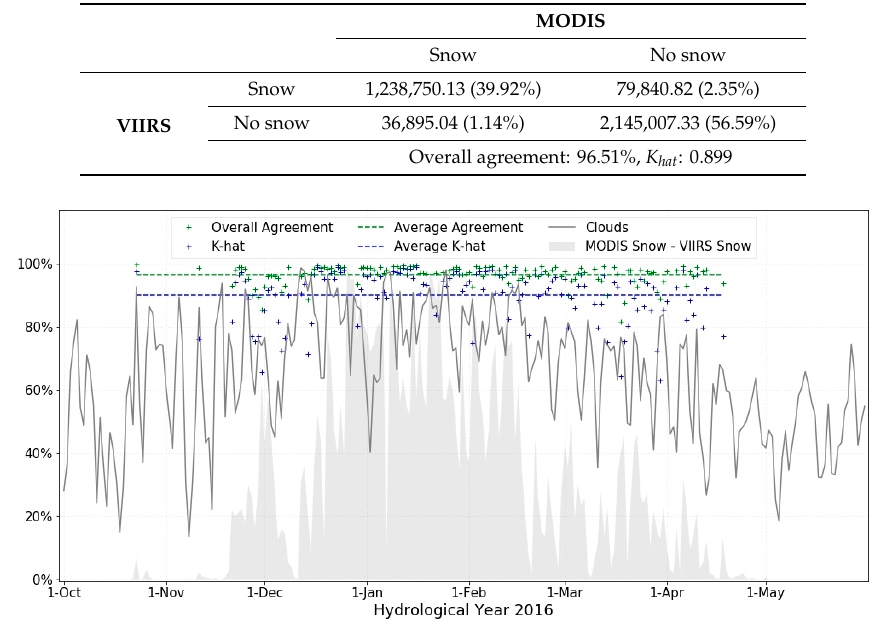
Figure 8. Marker plots showing improvement in Kappa statistics between MODIS and VIIRS snow maps with respect to each day of the 2016 hydrological year. The green and blue dash lines respectively represent the average overall agreement (96.51%) and average kappa statistics (0.899) between MODIS and VIIRS snow maps.